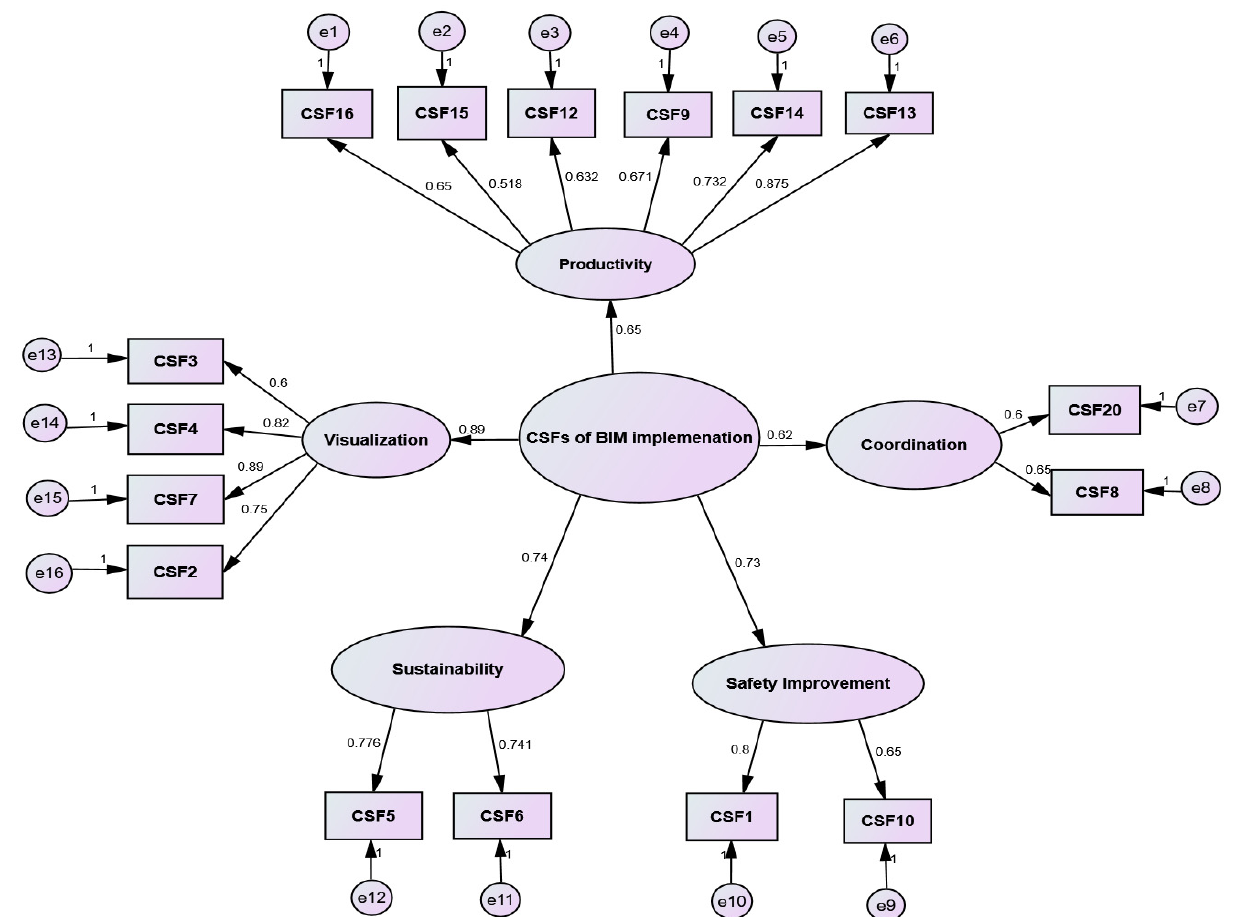
Figure 5. Model development for BIM implementation.